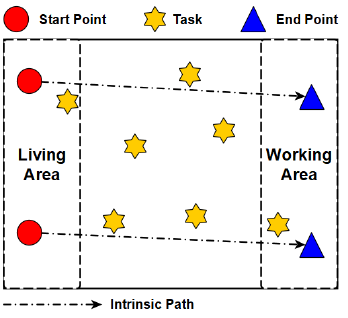
Figure 2. An example